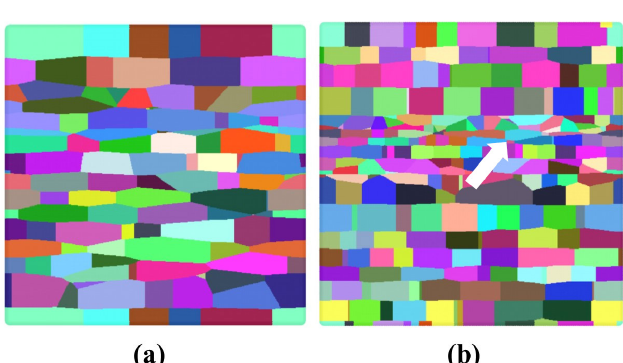
Figure 3. Longitudinal section showing the fully transformed microstructure of oblate ellipsoids nucleated on 20 random parallel planes. The ratio of the length of the longer axes to the shorter axis of the ellipsoid is 4:4:1. The nucleation was site-saturated. That is, all nuclei started to grow at the time origin: t 0 = . The figures depict microstructures that show the effect for the number of nuclei per plane: a) 20 nuclei on each plane; b) 80 nuclei on each